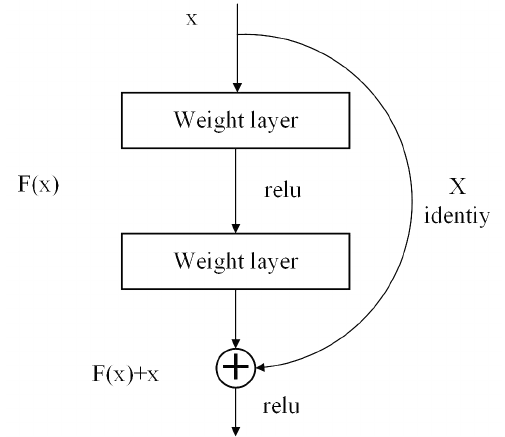
Figure 5. Residual